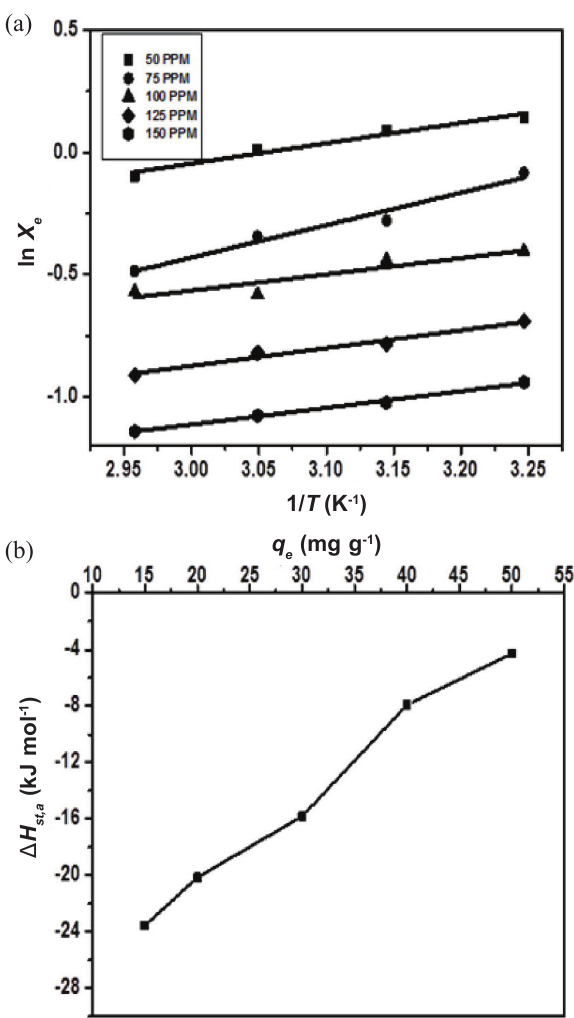
Fig. 8 – (a) Van’t Hoff plot for the 2-CP-RSAC adsorption system (X = 50–150 mg L –1 ; t= 125 min; w = 1.25 g L –1 ; pH = 8), o (b) Isosteric heat of adsorption (ΔH ) based on surface load- st,a ing for 2-CP adsorption onto